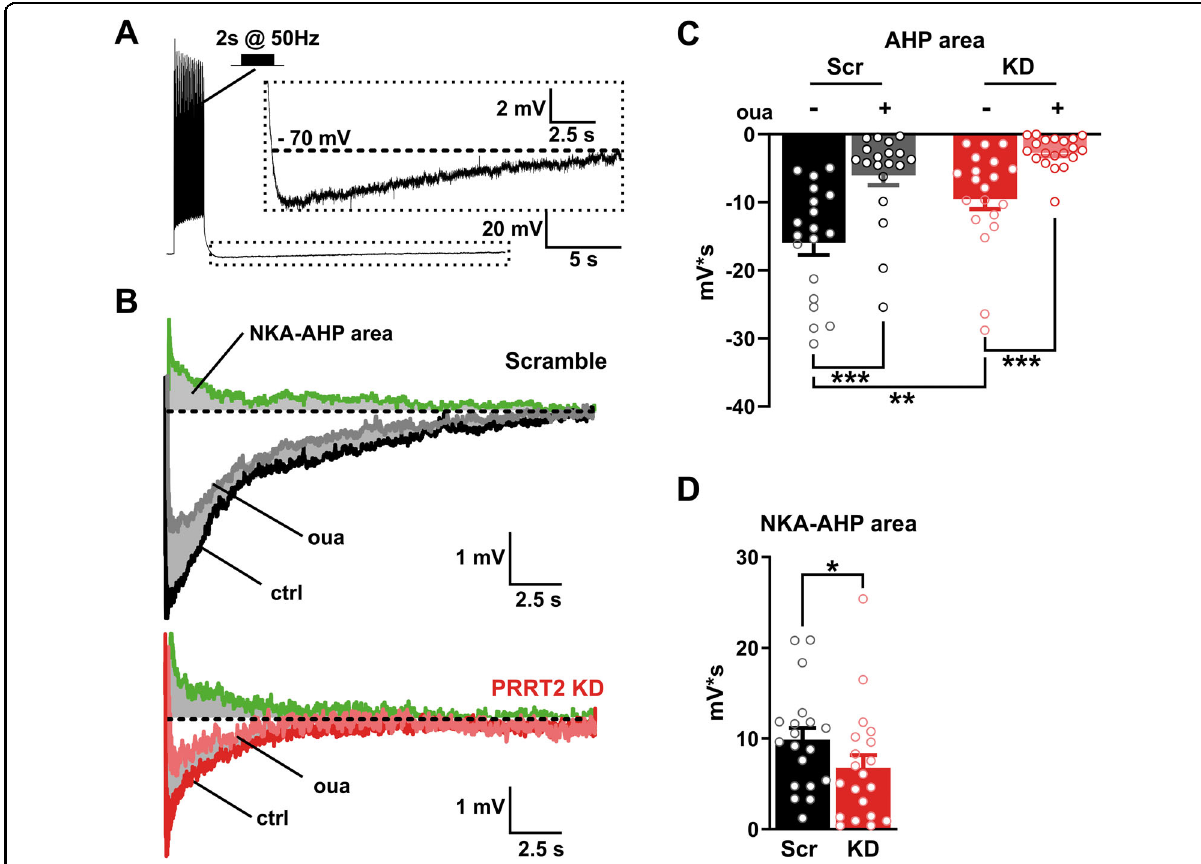
Fig. 6 Acute PRRT2 deletion decreases the activation of NKA evoked by high-frequency stimulation. A AHP induction protocol. Neurons were kept in whole-cell current-clamp con fi guration and APs were evoked by delivering supra-threshold current pulses at 50 Hz for 2 s. Inset: expanded view of the AHP phase indicated by the dashed box. The black dashed lines indicate the holding potential ( − 70 mV). B Representative AHP traces recorded from Scr (top) and PRRT2 KD (bottom) neurons before (ctrl) and after the application of ouabain (oua, 1 mM). The NKA-induced AHP was obtained by digital subtraction of the response in the presence of ouabain from the control response (green traces). Gray-shaded areas indicate the NKA-induced AHP component. C The areas under the AHP waveform, baselined to − 70 mV and within a time window of 20 s after the train, were measured in Scr and PRRT2 KD neurons before and after ouabain blockade. D The areas of the NKA-dependent AHP in Scr and PRRT2 KD neurons were obtained from the difference between individual AHP areas before and after ouabain blockade ( n = 19 and 20 for Scr and PRRT2 KD, respectively, from three independent neuronal preparations). Bar plots show the means ± SEM with superimposed individual experimental points. * p < 0.05, ** p < 0.01, *** p < 0.001; two-way ANOVA/ Š ídák ( C ); unpaired Student ’ s t -test ( D